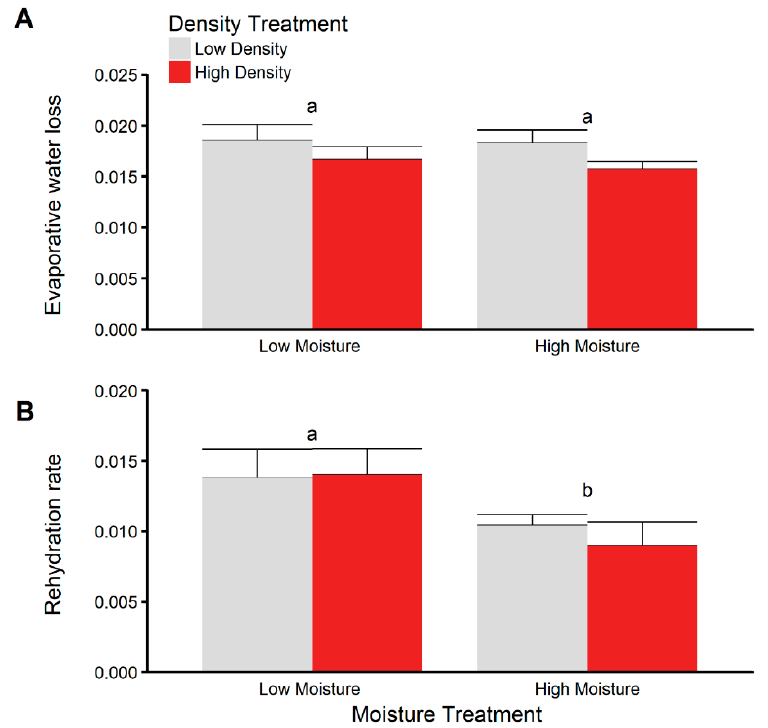
Figure 6. ( A ) Evaporative water loss (g cm − 2 h − 1 ) across low and high terrestrial moisture treatments and low larval density (grey bars) and high larval density (red bars) + SE and ( B ) Rehydration rate (g cm − 2 h − 1 ) across low and high terrestrial moisture treatments and low larval density (grey bars) and high larval density (red bars) + SE. Letters over bars represent significant differences between moisture treatments at p = 0.05.